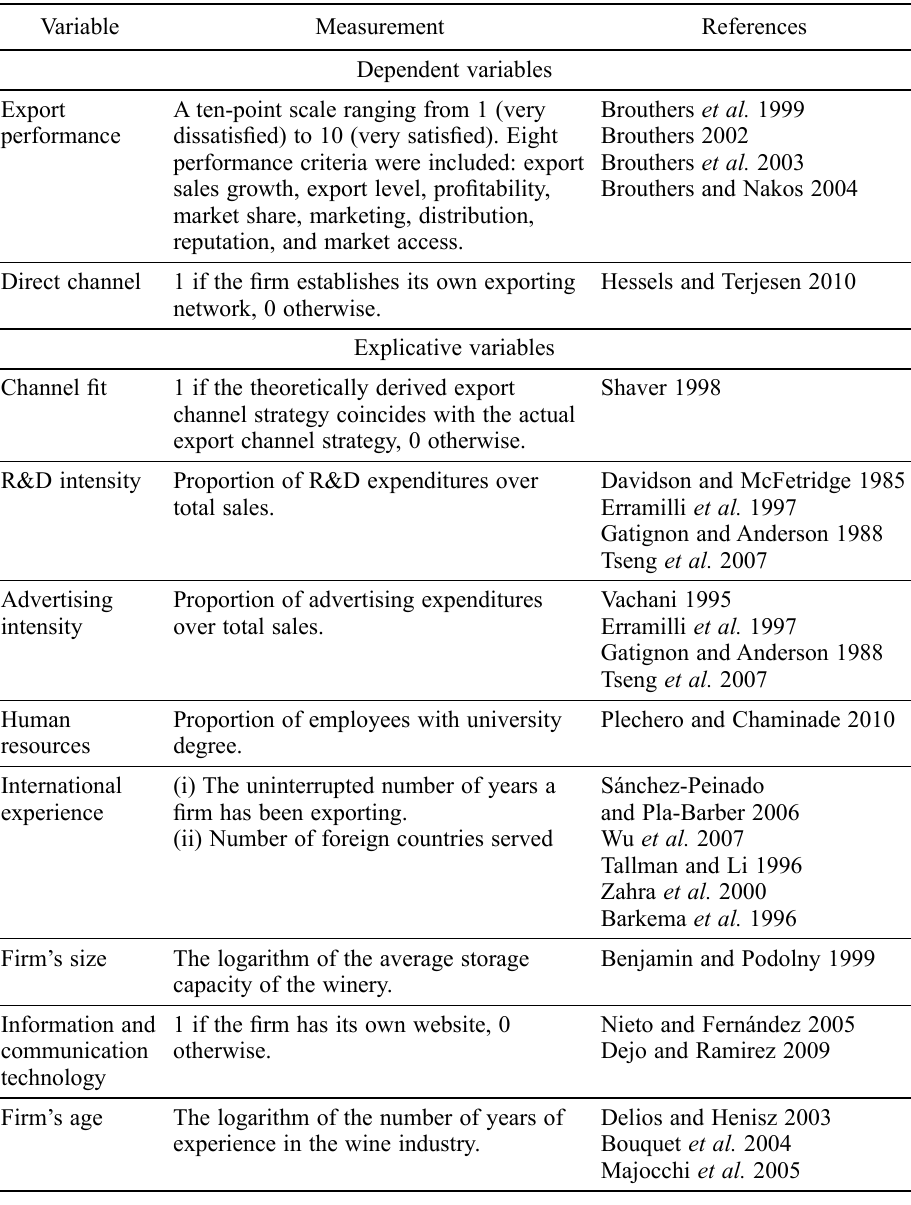
Table 1. Measurement of